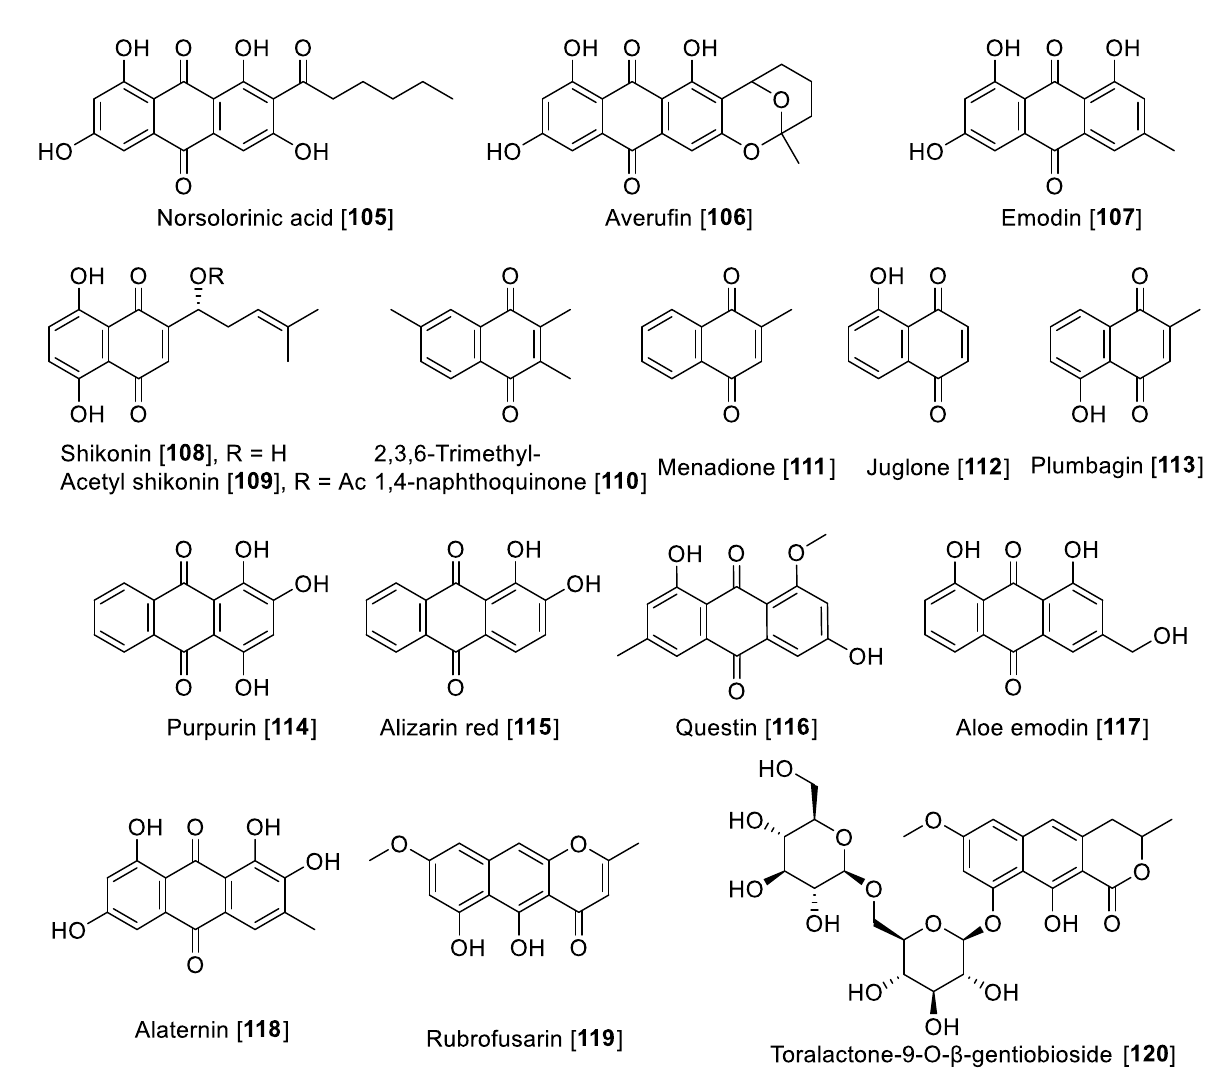
Figure 11. Chemical structure of selected naphthoquinone and anthraquinone MAO inhibitors.